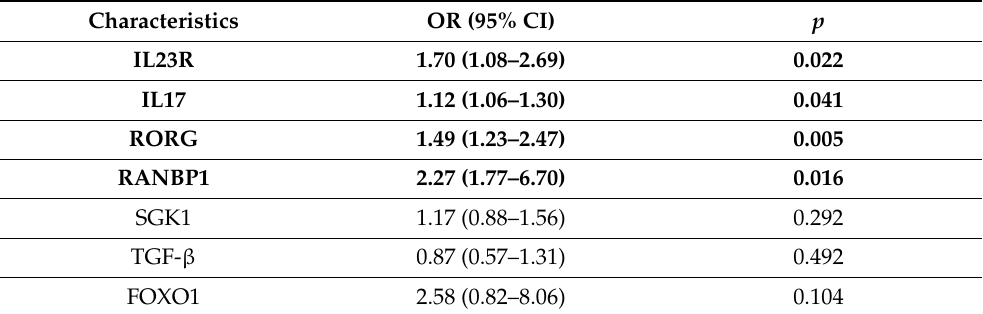
Table 2. Multivariable ordered logistic regression analyses for the predictors of change status from CTRL to CVD and to CVULs.